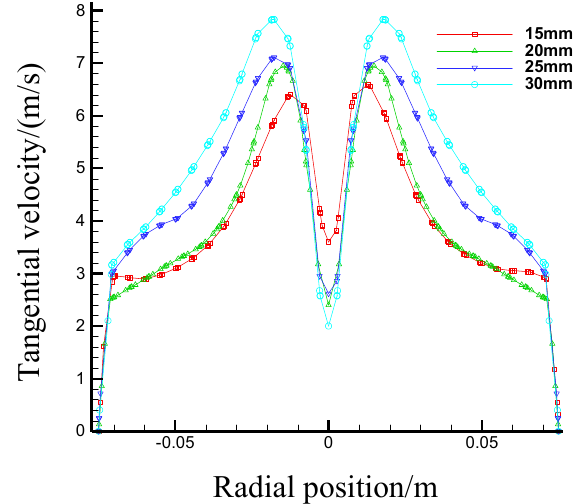
Figure 12. Velocity distribution of the hydrocyclone with a different inner vortex finder.